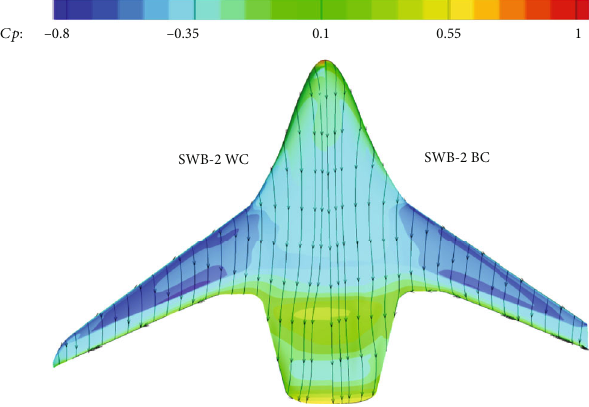
Figure 20: The surface pressure and streamlines of SWB-2 WC and BC at cruise speed, α = 1 : 5 ° .